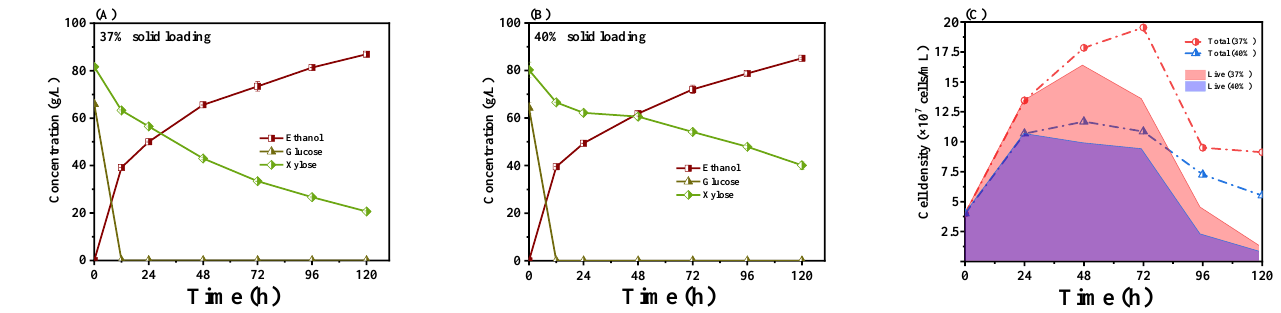
Figure 6. SSCF of DLCA(sa)-CC at ultra-high solids loadings; ( A ) 37% solid loading; ( B ) 40% solid loading; ( C ) cell density. DLCA(sa)-CC was pre-hydrolyzed for 18 h at 50 °C, 250 rpm, and pH 4.8 with an enzyme dosage of 20 mg protein/g glucan. SSCF with S. cerevisiae CRD5HS (initial OD 600 = 4) was conducted at 30 °C, 150 rpm, and initial pH 5.5 for 120 h.